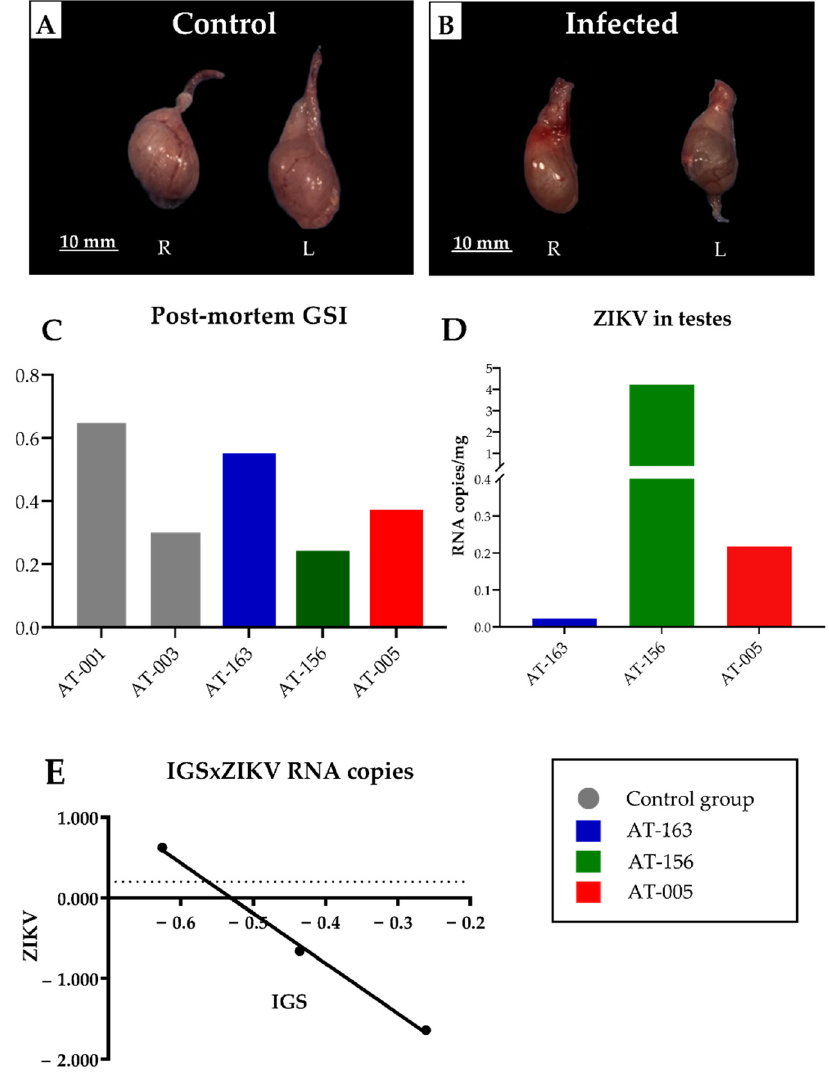
Figure 4. Postmortem evaluation of experimental ZIKA infection in male S. collinsi . ( A ) Control animal AT-001, macroscopy of the right and left testes. ( B ) Infected animal AT-156, macroscopy showing a slight difference in size between the right and left testes. ( C ) Postmortem GSI graph at 21 dpi of each animal. ( D ) Graph of the detection of ZIKV RNA copies/mg in a pool of both testes of each infected animal. ( E ) Graph of Pearson’s correlation: demonstrating a significant inverse and very strong correlation between GSI X ZIKV tissue variables, R-value = − 0.9986 and p = 0.033.